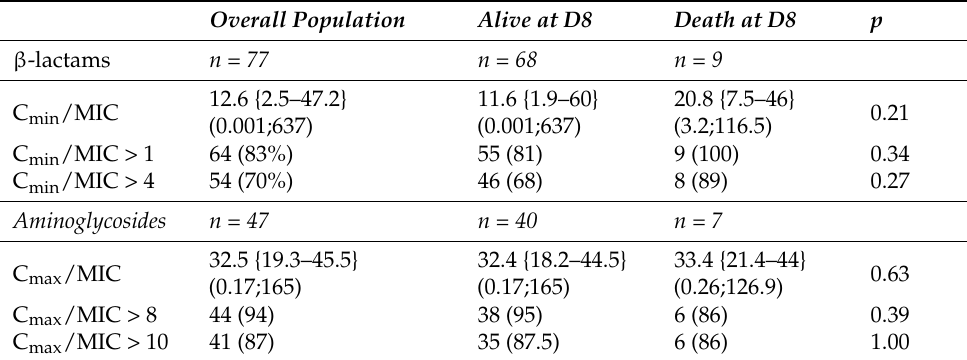
Table 5. Pharmacokinetic and pharmacodynamic parameters of the patients and comparison accord- ing to clinical outcome.